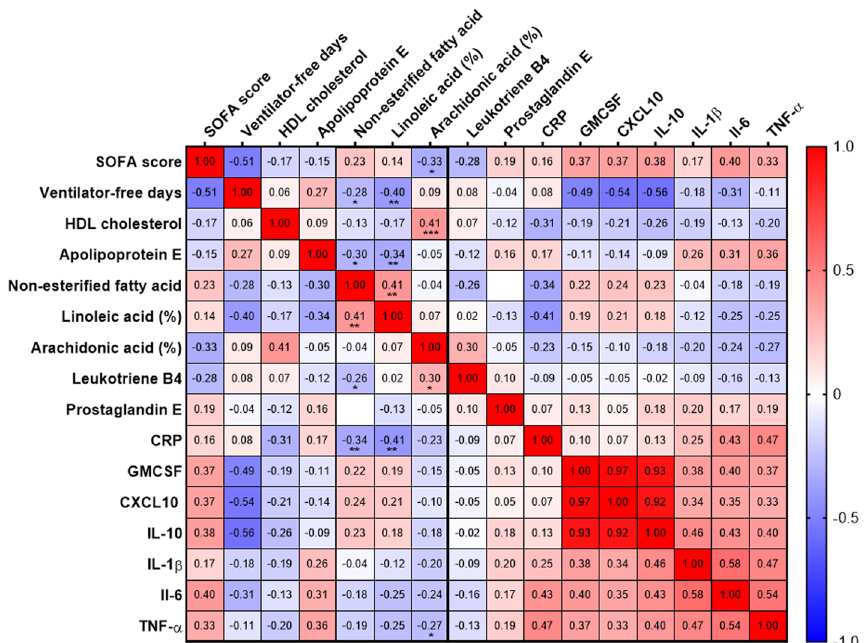
Figure 4. Correlations between NEFAs, PUFAs proportion, inflammation, and outcomes. Heatmap of the Spearman correlation (r) between lipids parameters, clinical severity and outcome, plasma cytokine concentrations. Spearman correlations : p < 0.05, * p < 0.01, ** p < 0.001, ***between each variable. CRP: C-reactive protein; GMCSF: granulocyte–macrophage colony-stimulating factor; HDL: High density lipoprotein; IL: interleukin; SOFA: sequential organ failure assessment; TNF-α: tumor-necrosis factor